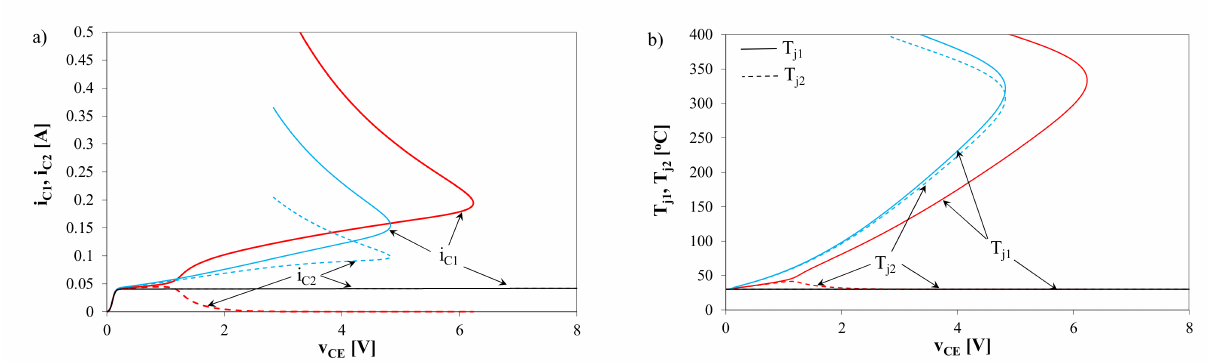
Figure 12. Computed non-isothermal dc current-voltage characteristics ( a ) and dependences of junction temperature on v CE voltage ( b ) of parallelly connected BJTs operating at different cooling